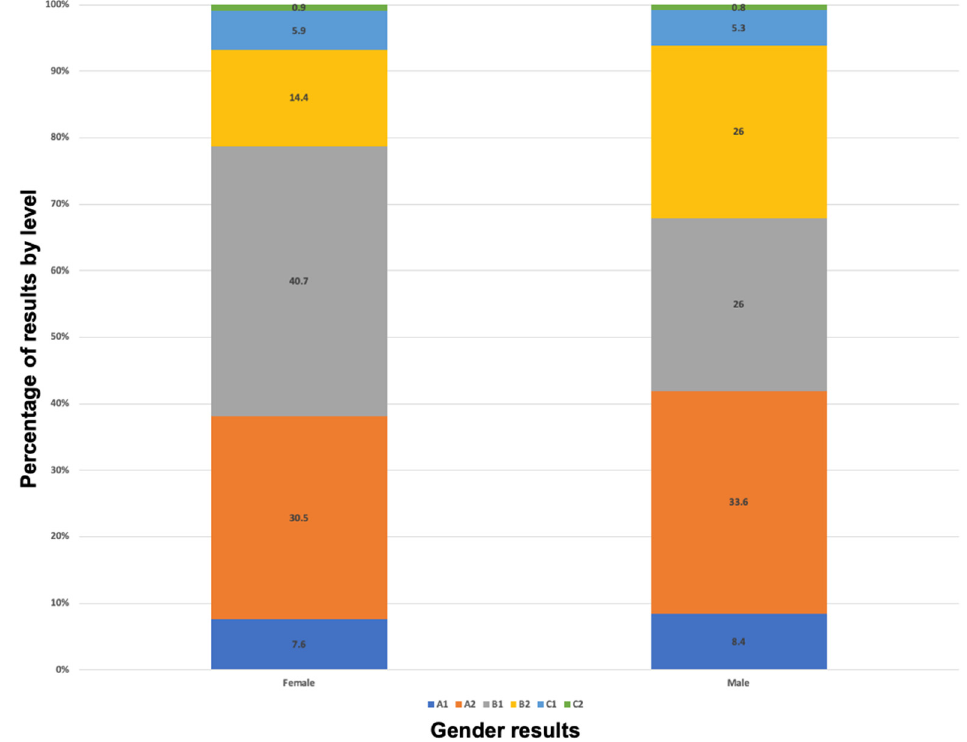
Figure 4. Percentage of results by level and gender.